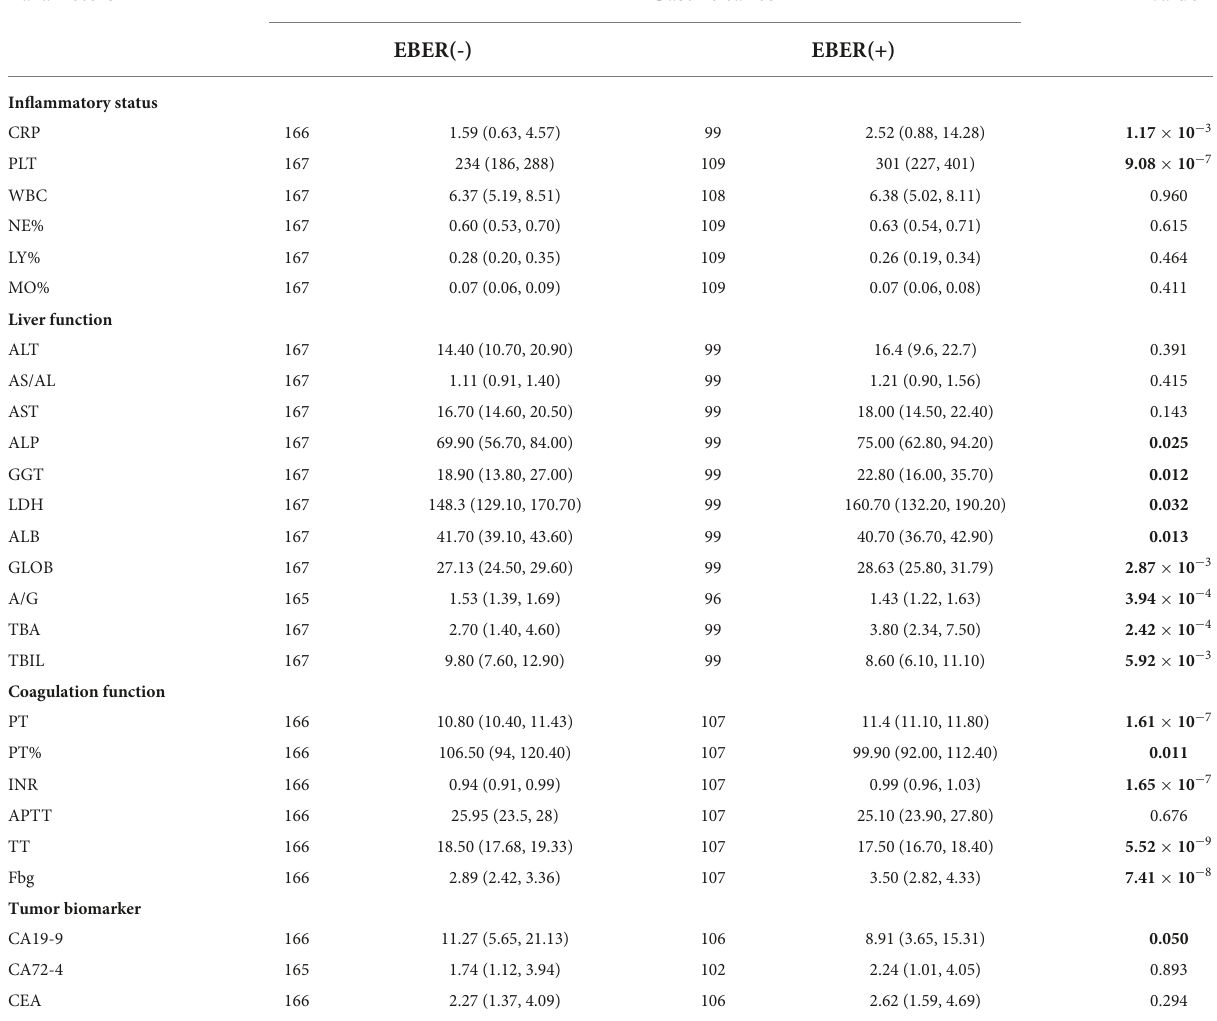
TABLE 1 Comparison of laboratory testing between the patients with and without Epstein–Barr virus and gastric cancer. Parameters